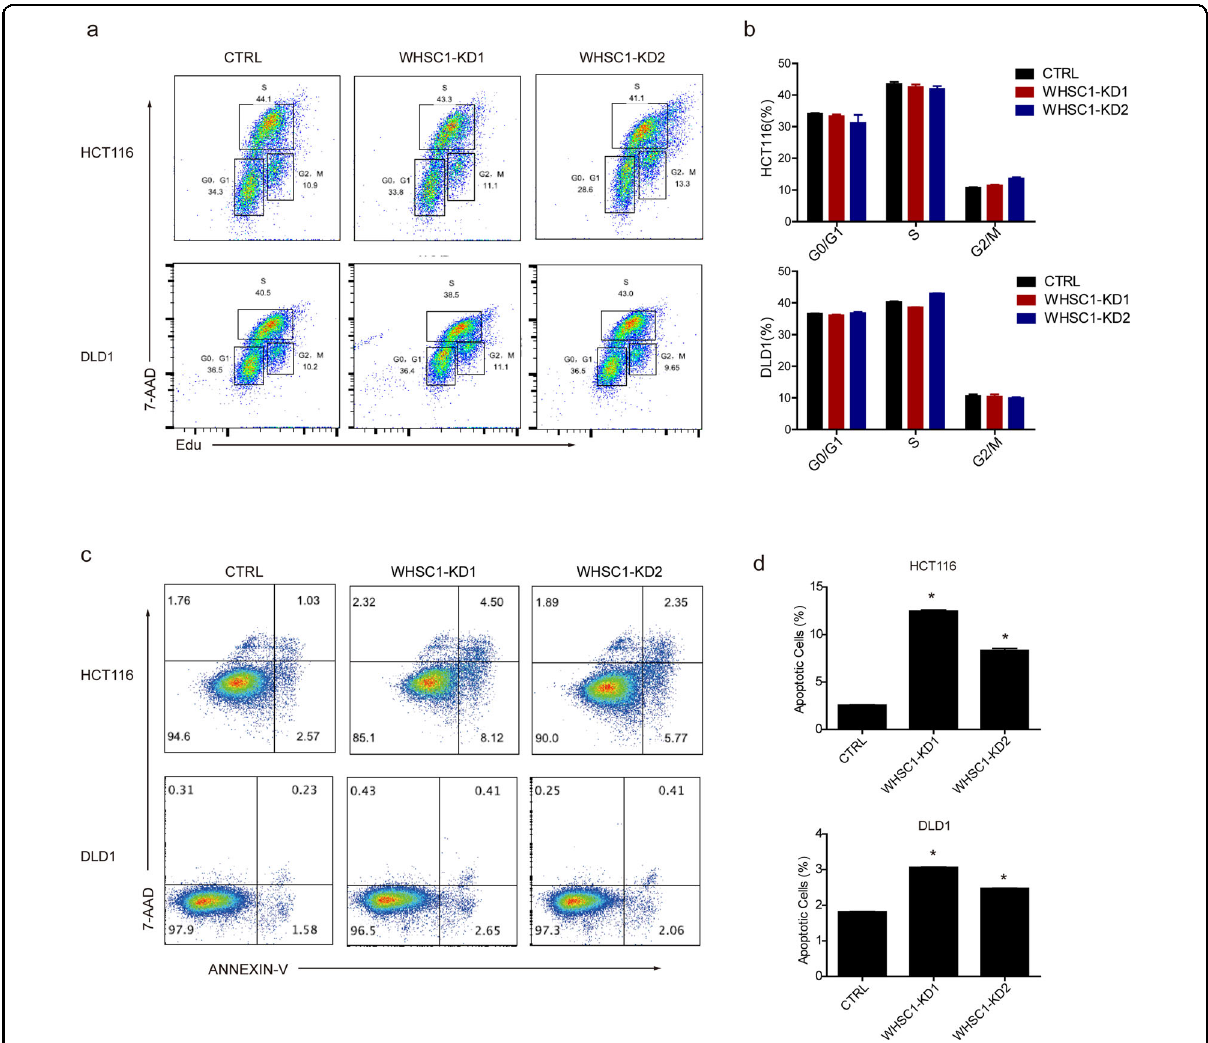
Fig. 3 WHSC1 ablation promotes CRC cell apoptosis. a Pro fi ling of the cell cycle distribution of HCT116 and DLD1 cells transiently expressing shCon, shWHSC1-1, or shWHSC1-2. b Quantitative analyses of the cell cycle distribution as described in ( a ), assessed by two-sided Student ’ s t test. c , d Flow cytometry pro fi ling and quanti fi cation of Annexin-V/7-AAD-stained cells transiently expressing shCon, shWHSC1-1, or shWHSC-2. All data represent the mean ± S.D. of three independent experiments, * P < 0.05, ** P <